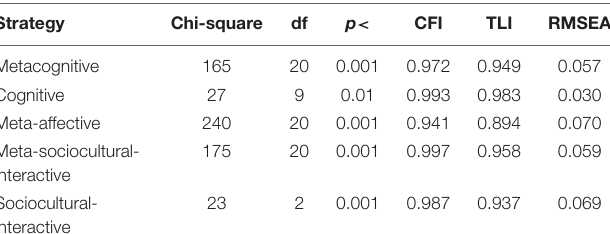
TABLE 2 | Goodness of fit indices for questionnaire fields.